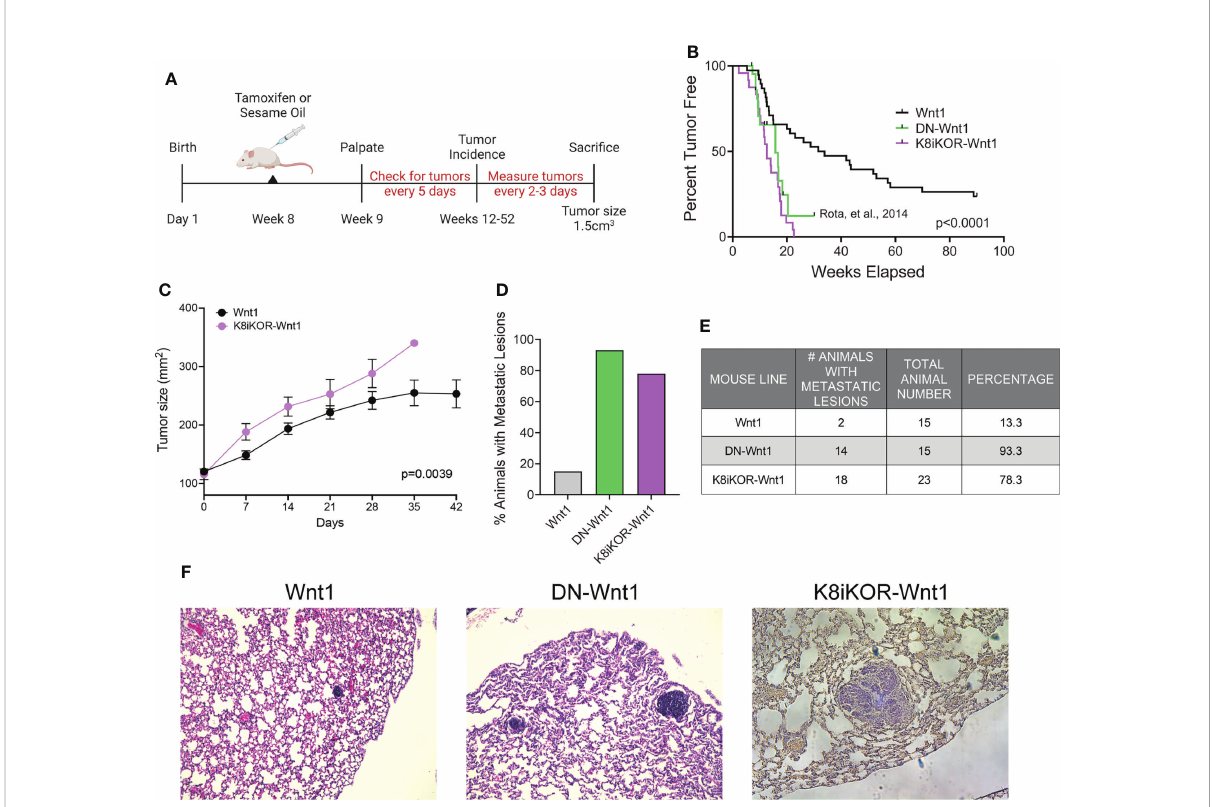
FIGURE 2 Luminal loss of IGF1R decreases tumor latency and increases metastasis. (A) Schematic for luminal lineage Igf1r knockout. (B) Latency curve for tumor development in Wnt1, DN-Wnt1, and K8iKOR-Wnt1 animals. For K8iKOR-Wnt1 animals, tumor latency is weeks post tamoxifen injection. Statistic: Mann-Whitney test (C) Growth curve after tumors arise until time of euthanization. Statistic: Non-linear regression best fi t for line slopes. (D, E) Graph of the percentage of animals (D) and table of number of animals (E) with metastatic lesions after establishment of a primary tumor. Table Statistic : Chi-square test; p = 0.0251 for Wnt1 vs. DN-Wnt1 and K8iKOR-Wnt1. For Wnt1 controls, vehicle and tamoxifen injected animals were combined as the phenotypes were equivalent. (F) Micrograph images showing examples of metastases in H&E stained lung sections from Wnt1, DN-Wnt1 and K8iKOR-Wnt1 mice with primary